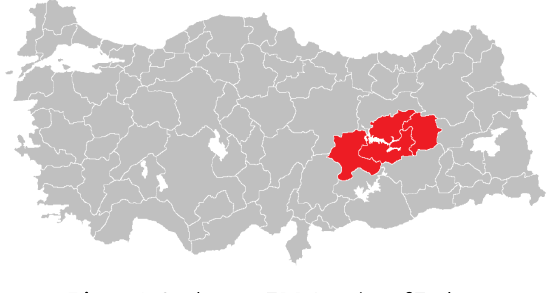
Figure 1. Study area: TRB1 region of